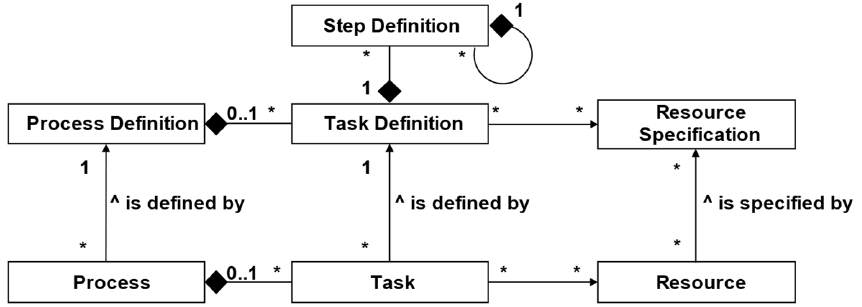
Figure 6. Top-level logical data architecture used in SHOP4CF [32]. The notation used is based on the UML and defines the cardinality between the different data models. This architecture is used to structure the MES database. In this architecture, the process definition and process are of utmost importance. These refer respectively to a high-level process definition, which was initially given by a BPMN model, and to a process representation with clearly mapped resources.